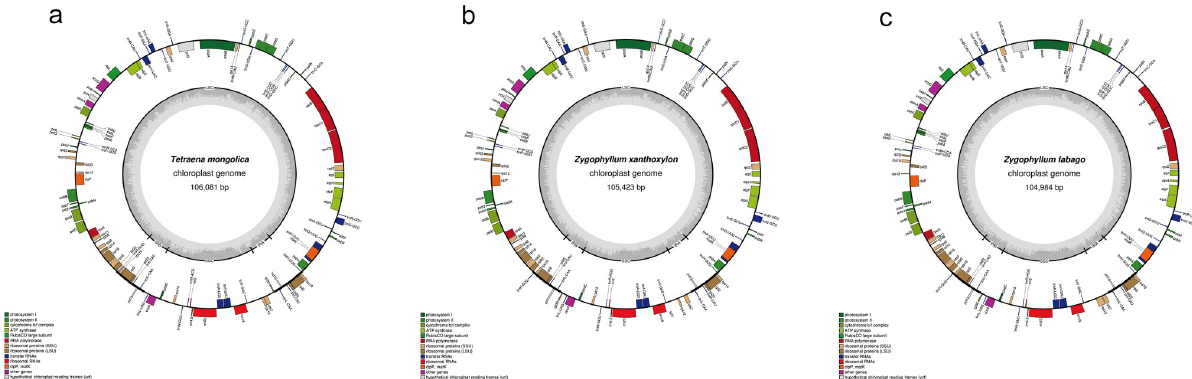
Fig 1. The complete chloroplast genome of T . mongolica (a), Z . xanthoxylon (b) and Z . fabago (c). The predicted genes are displayed and colors indicate functional classifications in the legend. The genes outside the circle are transcribed clockwise, whereas those inside the circle are transcribed counterclockwise. The inner gray circle describes the GC content. The large single copy (LSC), small single copy (SSC) and inverted repeat (IR) regions are marked in the inner circle.